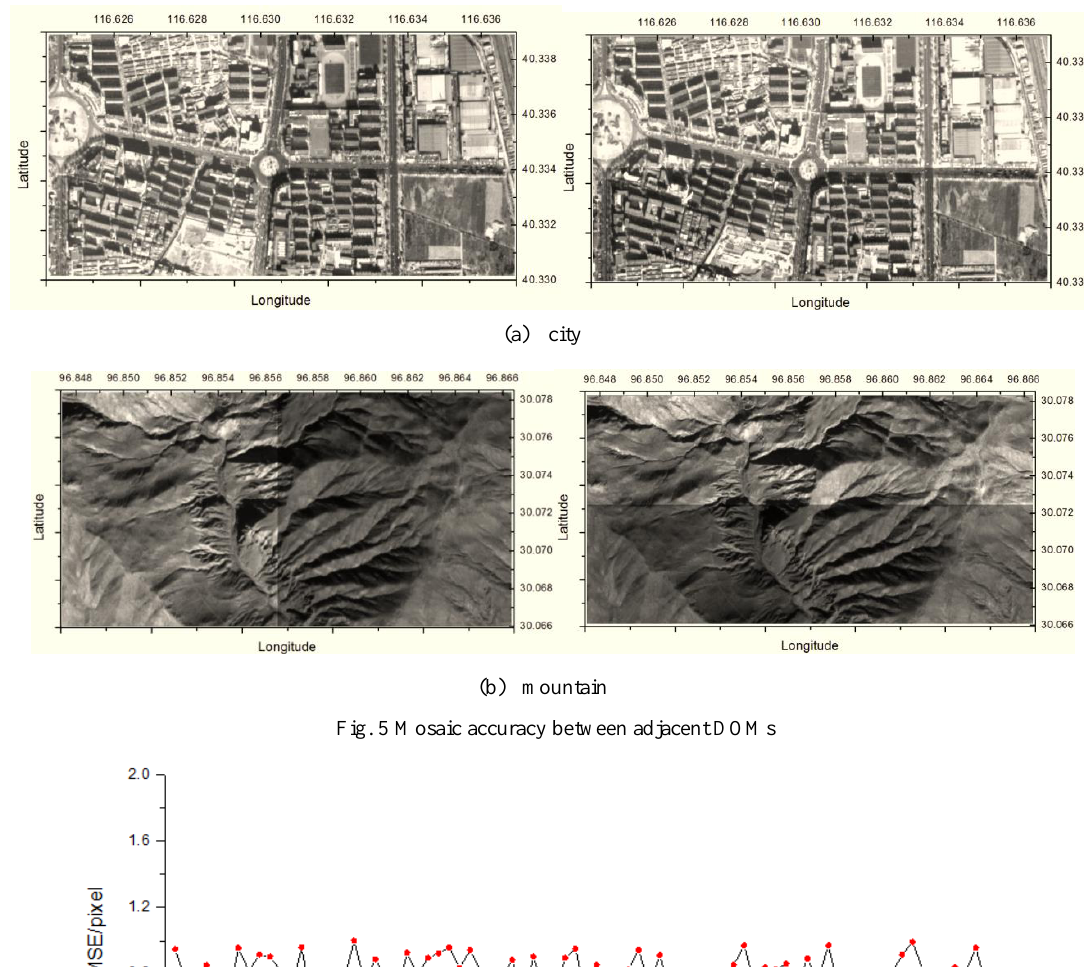
Fig. 6 RMSE of mosaic between adjacent